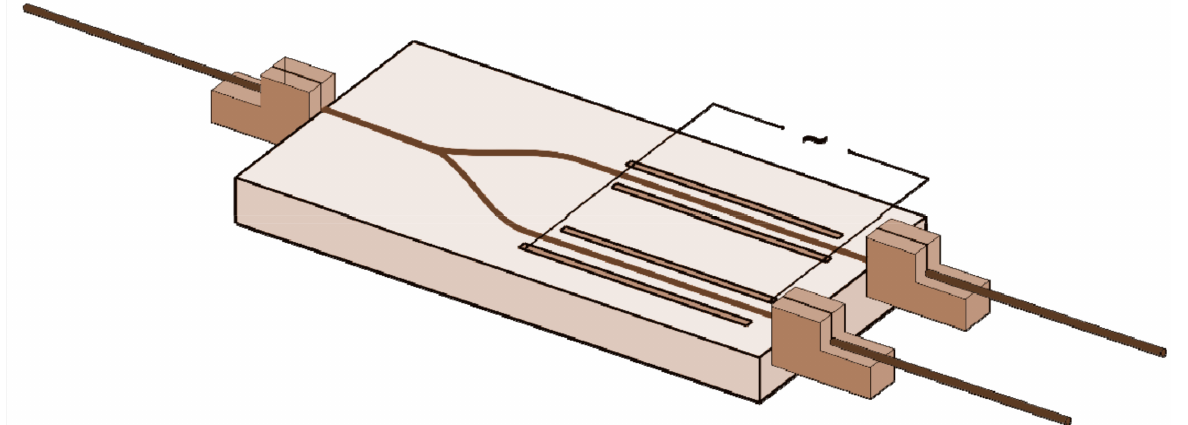
Figure 1. Schematic diagram of studied sample.